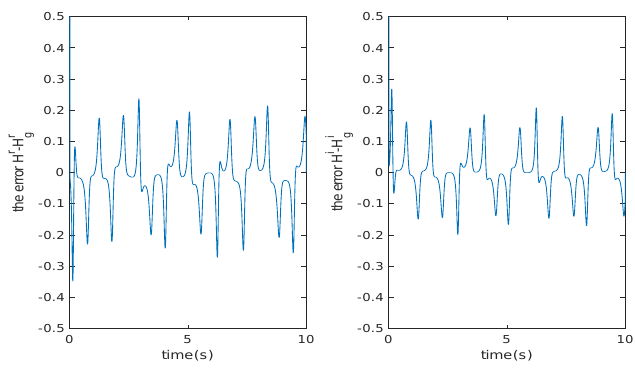
Figure 12. The error between message signal H and H g